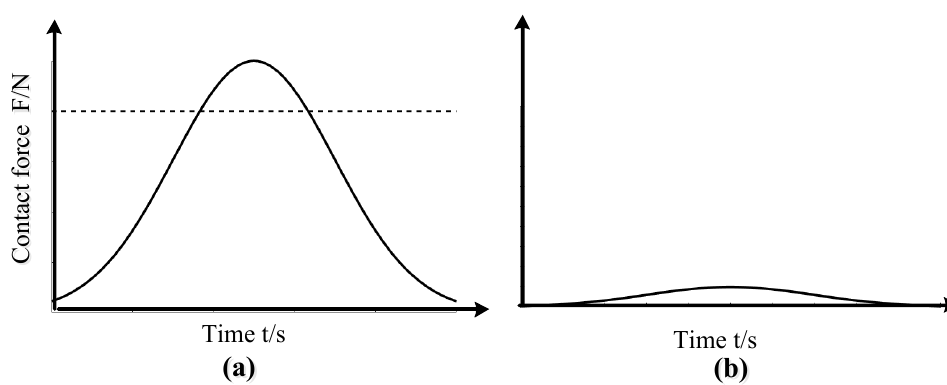
Figure 9. Single round adaptive evaluation model: ( a ) Contact force curve; ( b ) Adaptive evaluation curve.